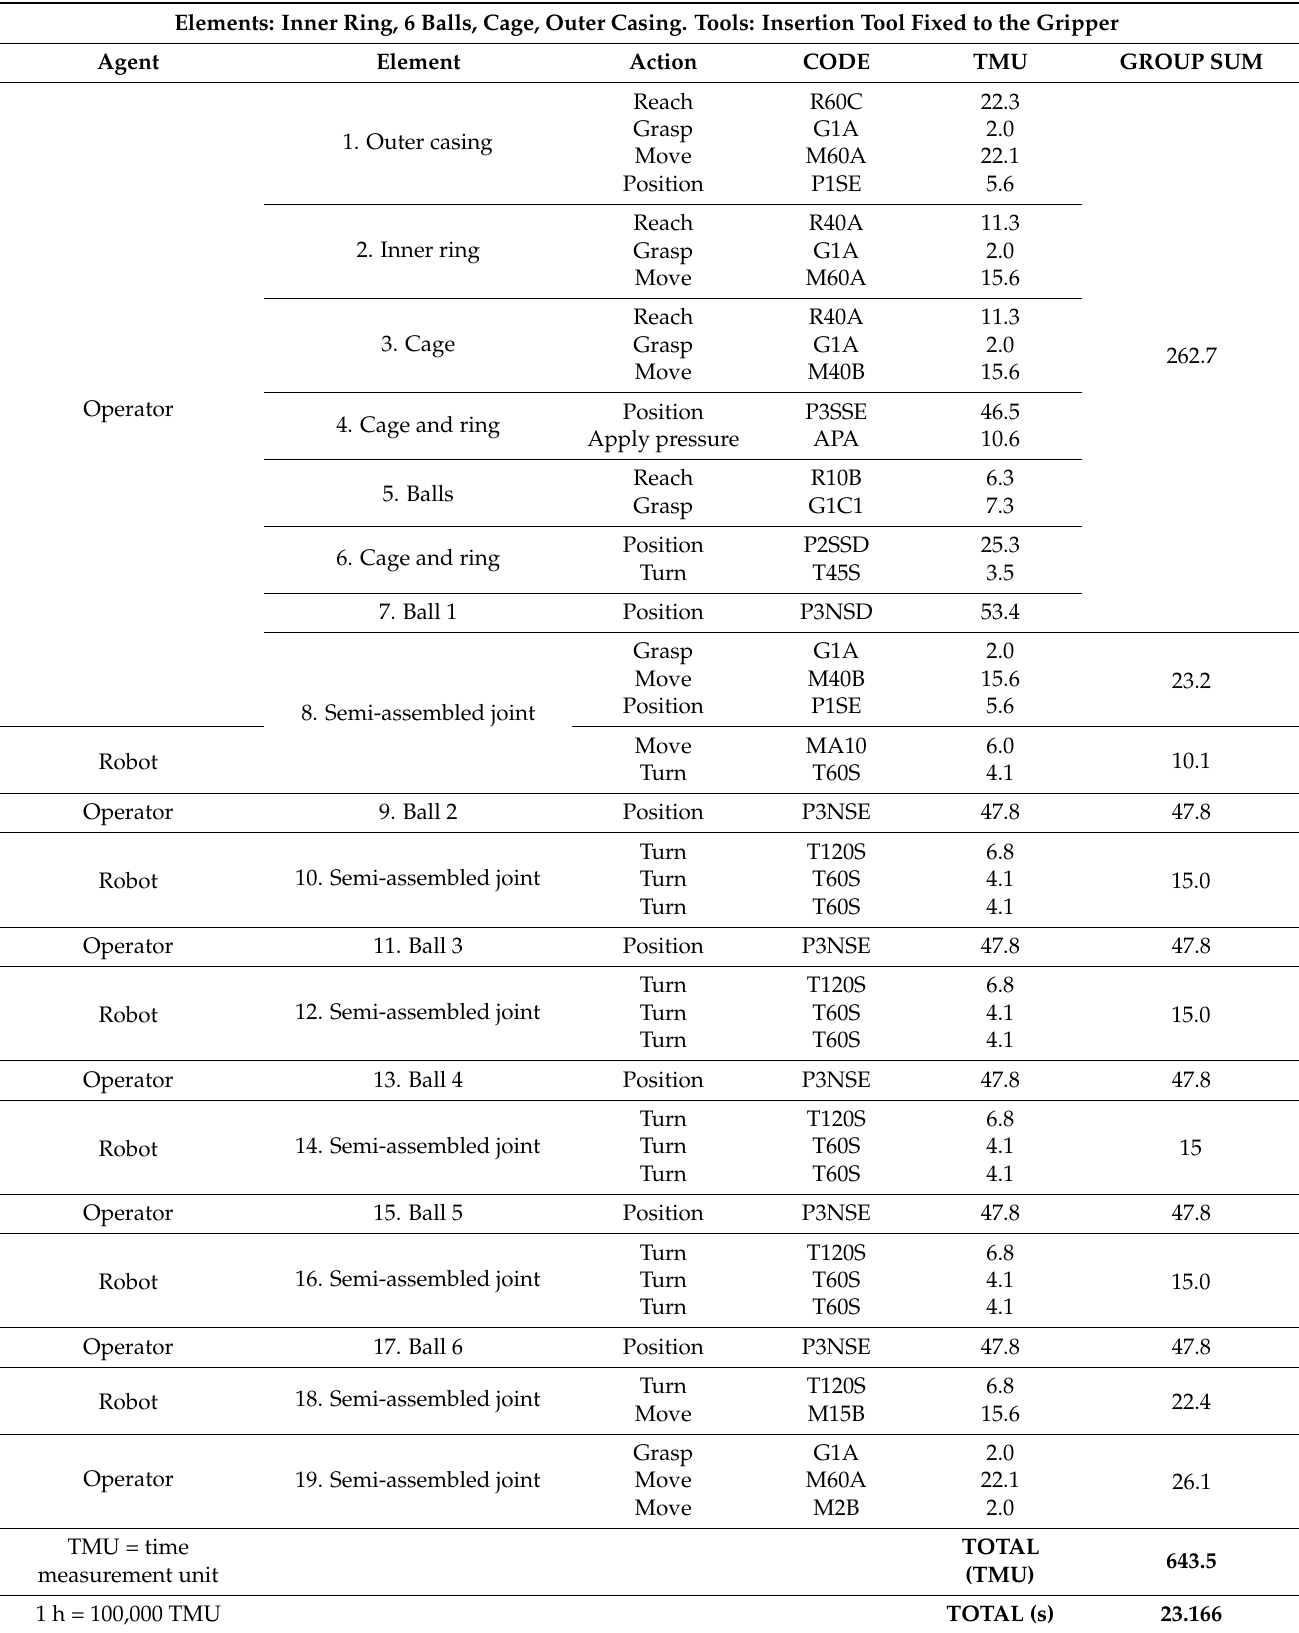
Table 3. MTM for the assembly of a Rzeppa homokinetic joint and process timeline